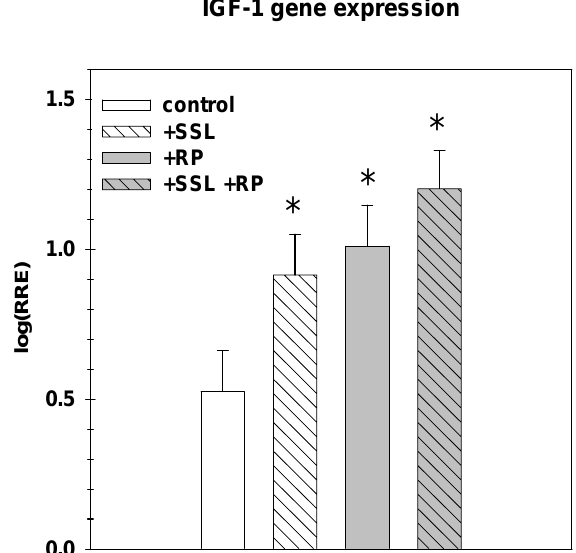
Figure 12: Simulated solar light and retinyl palmitate increase mRNA levels for insulin-like growth factor-1. Groups of HR/Skh-1 hairless mice (n=13) were exposed to simulated solar light (SSL) and/or 13% retinyl palmitate (RP) three times per week for 13 weeks. Whole skin samples were collected in RNAlater (Ambion) 48 hours after the final treatments. Total RNA was extracted using RNeasy Mini kits (Qiagen). IGF-1 and 18S rRNA levels were determined using qRT-PCR. The relative ratio of expression (RRE) for each group was calculated by the method of Pfaffl (40). Log transformation was used to normalize the data prior to Two Way ANOVA ( p <